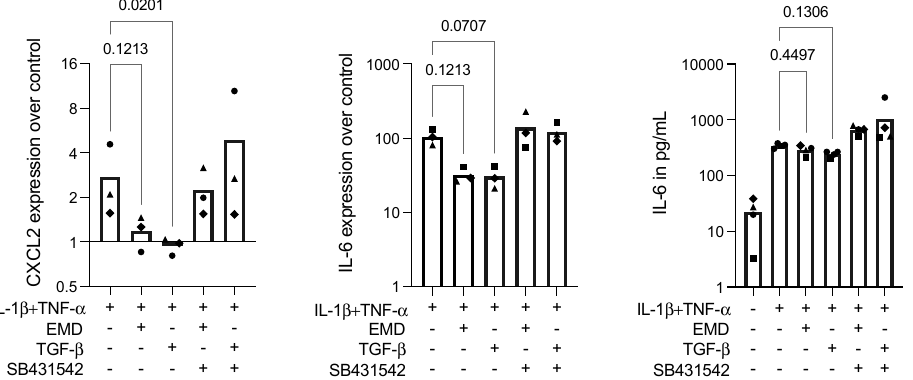
Figure 5. Gene expression of CXCL2 and IL-6, and IL-6 protein secretion in ST2 cells under IL- 1 β +TNF- α stimulation. TGF- β significantly reduced CXCL2 expression. EMD and TGF- β showed a trend in reducing CXCL2 and IL-6 at the transcriptional level, which was reversed by applying SB431542 in IL-1 β +TNF- α -stimulated ST2 cells. The protein levels of IL-6 in IL-1 β +TNF- α -stimulated ST2 cells were not significantly reduced by EMD or TGF- β . Each data point represents an independent experiment. To compare groups, the Friedman test followed by Dunn’s multiple comparison tests on the relevant groups were